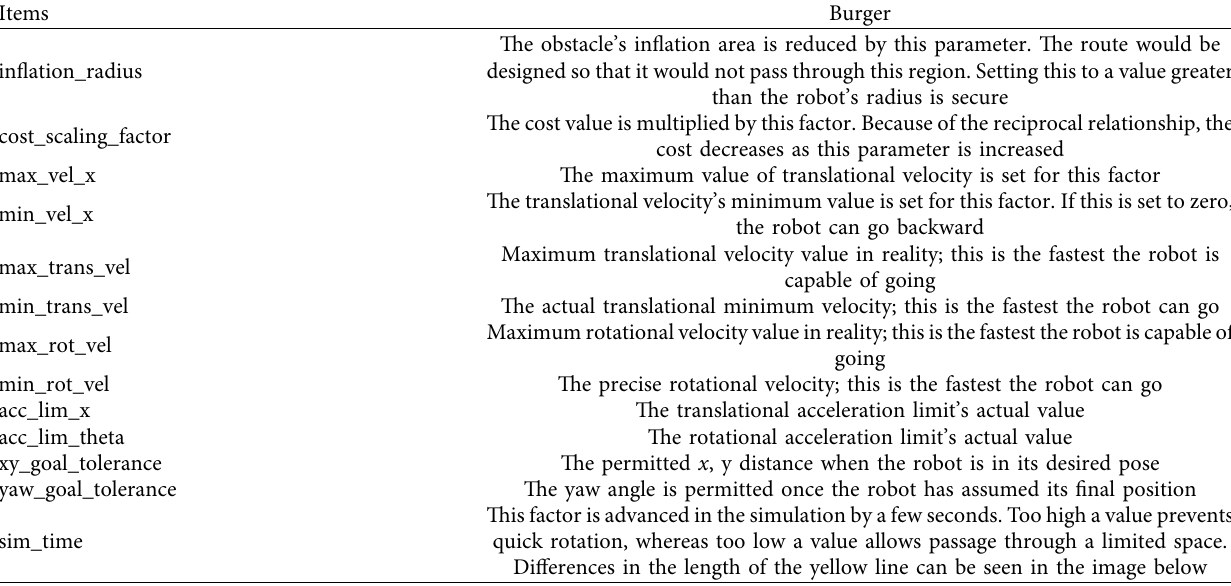
Table 6: Tuning guide of Turtlebot3